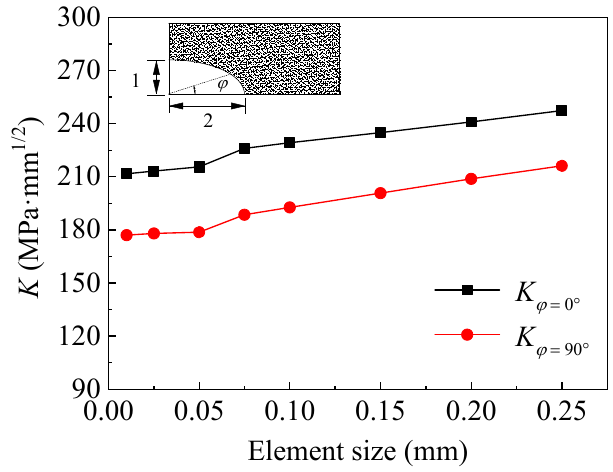
Figure 14. Variation in K -value with respect to element size. To further verify the reliability of the numerical modeling method proposed in this paper, the K -value along the crack front of the equivalent initial semi-elliptical surface crack in the un-strengthened corroded steel plate was numerically analyzed and compared with the calculation result of the Newman-Raju formula [52]. Figure 15 illustrates the comparison of K -values obtained by FEM and calculated adopting Newman-Raju formula, where the thickness and width of the steel plate are 10 mm and 35 mm, respectively; the depths of all the semi-elliptical surface cracks are 1.0 mm, and the depth/width ratio are presented as 0.50, 0.75, 1.00, 1.25, and 1.50, respectively; the applied load is 50 kN. As shown in Figure 15, the K -values along the front of the semi-elliptical surface cracks with different depth/width ratios obtained by FEM in this study present an excellent correlation with those calculated adopting the Newman-Raju formula. The average error of the numerical results with respect to the analytical value is only 1.75%. This indicates that the finite element model and calculation method of SIF proposed in this paper can be used to calculate the SIF values of semi-elliptical surface cracks in corroded steel plate strengthened with CFRP plates with reasonable accuracy.